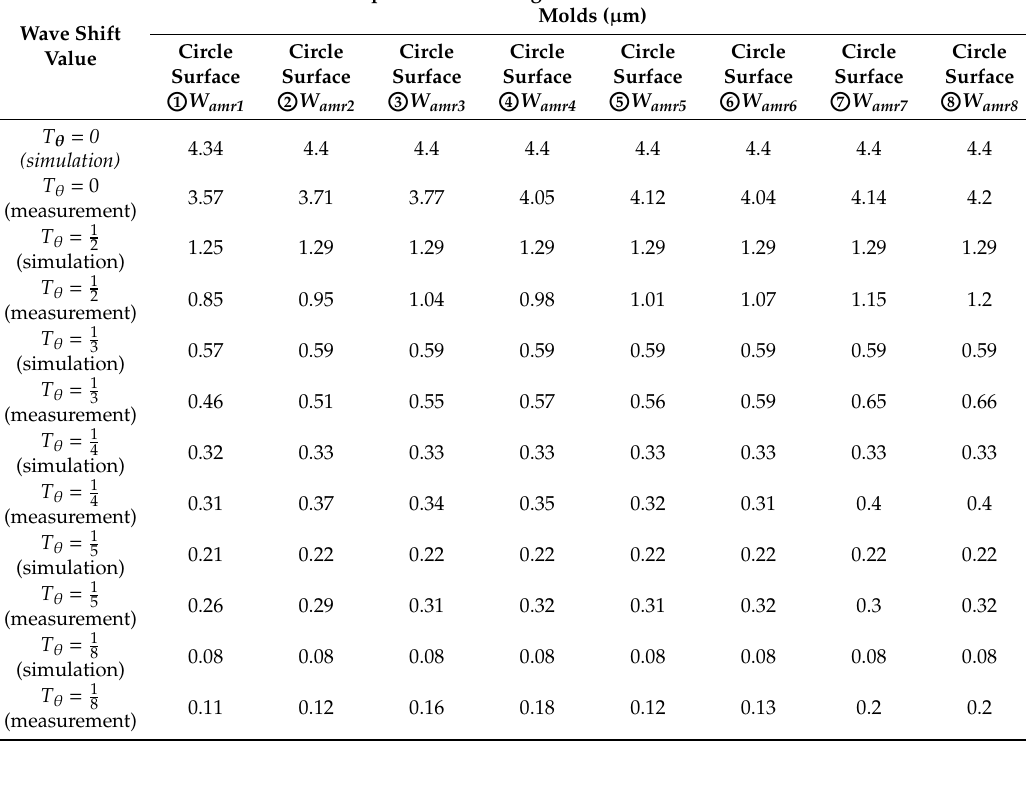
Table 3. Simulation and measurement results of the circular waviness amplitude on each circle surface of the Fresnel micro-structured molds.